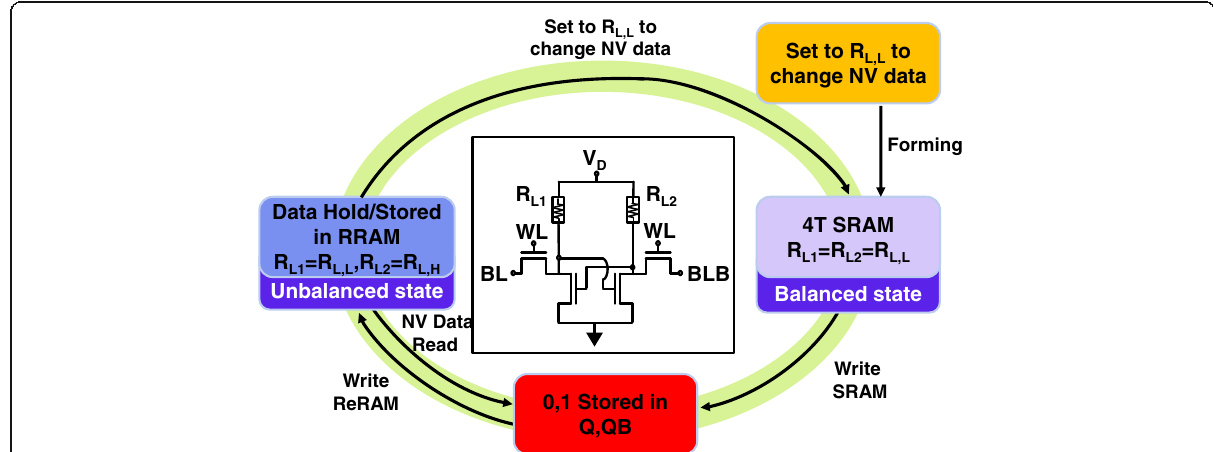
Fig. 6 Circuit schematic of nv-SRAM cell and its corresponding flow chart for switching between volatile and non-volatile SRAM operations